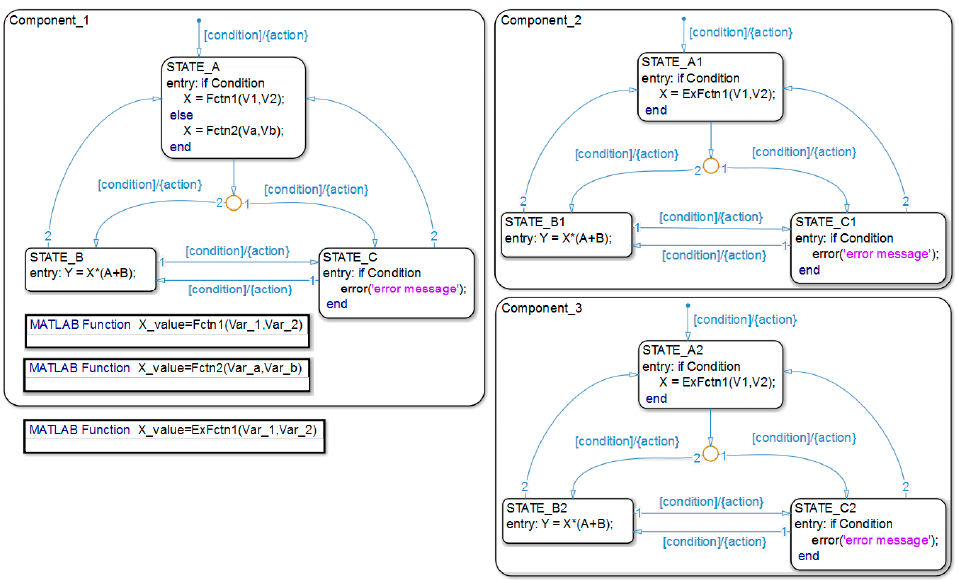
Figure 1. A general sensor node energy model using Stateflow charts.